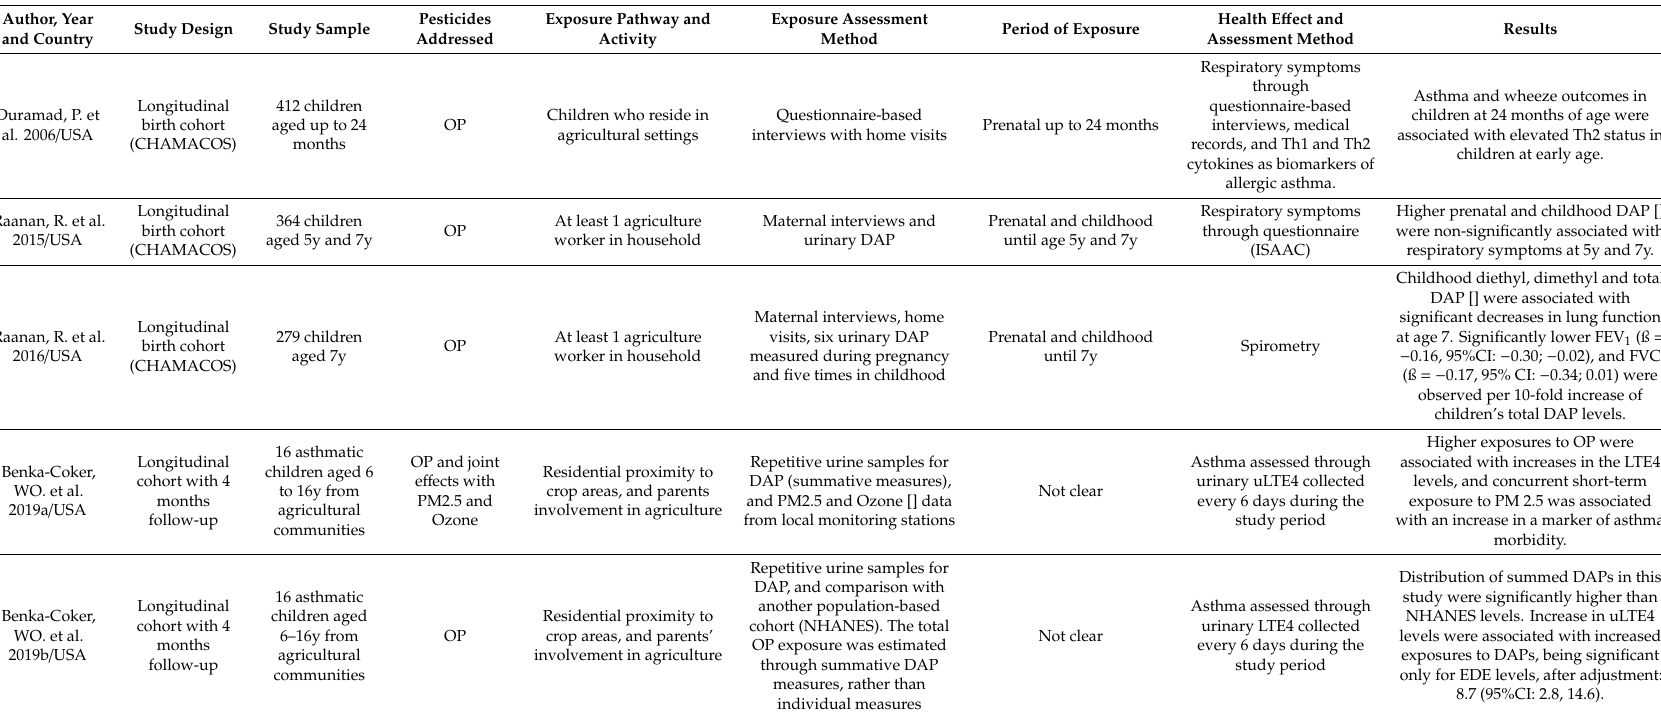
Table 1. Studies on respiratory and allergic e ff ects of organophosphate pesticides (OP) in